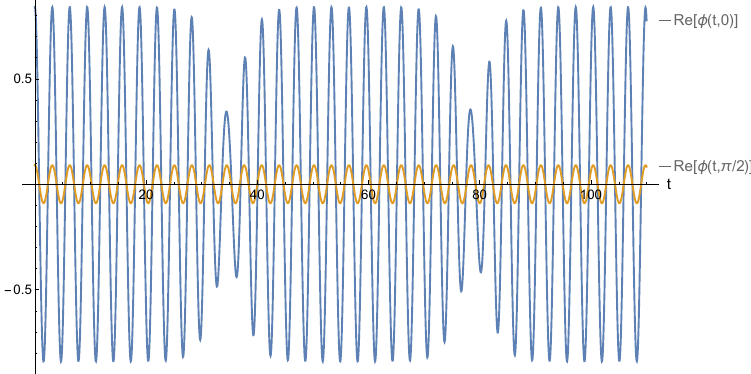
Figure 6 . In this plot we appreciate that the driven scalar (cid:12)eld keeps in phase with the driving all along its pro(cid:12)le. The tip at the origin and at the boundary rotate at the same pace. There is, a priori, no reason why this should be so and is not an artifact or truncation of the simulation. In fact one can (cid:12)nd (unstable) solutions where this is not the